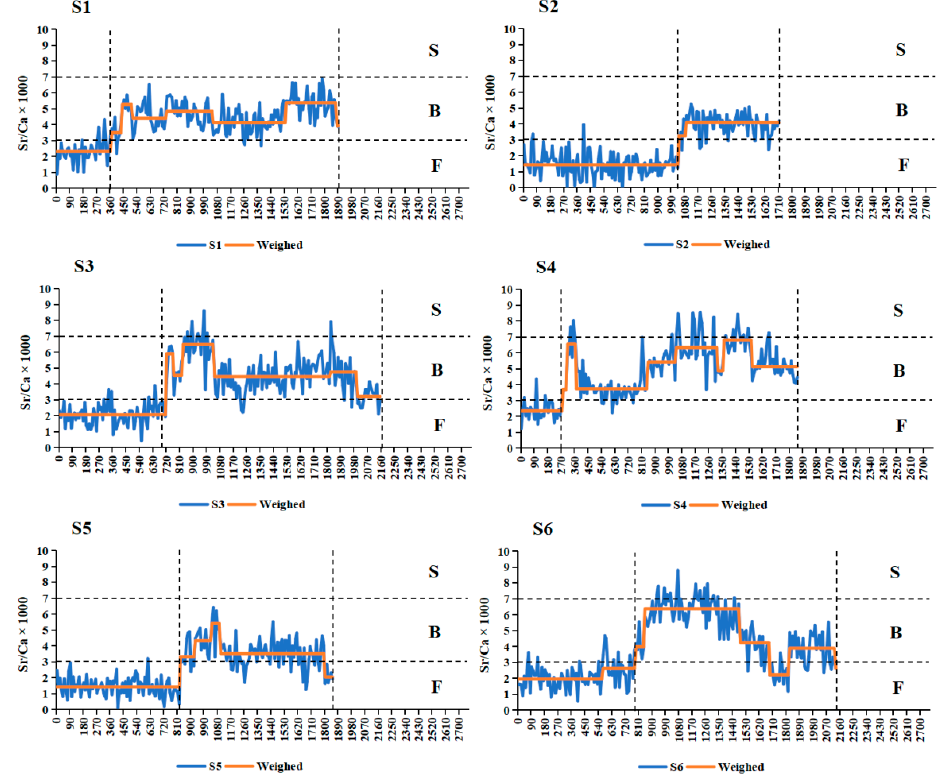
Figure 3. Fluctuation in otolith Sr/Ca ratios along line transects from the core (0 μ m) to the edge in the sagittal plane of the otoliths of different Coilia nasus groups along Shengsi Sea area. Orange solid line represents the Sr/Ca ratios after trend conversion; blue solid lines represent actual Sr/Ca ratios. S: seawater, B: brackish water, F: fresh water.